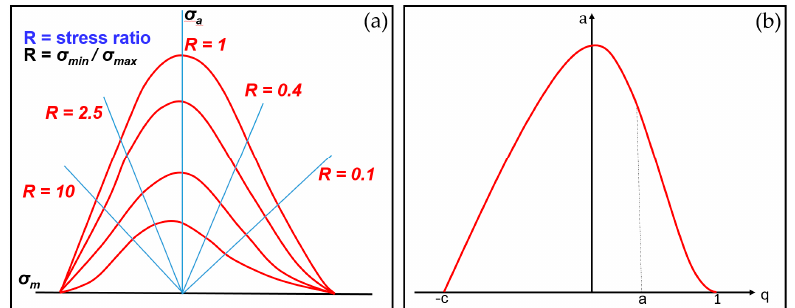
Figure 1. ( a ) Schematic of a typical constant life diagram; ( b ) Normalized fatigue life model derived from constant life diagram.